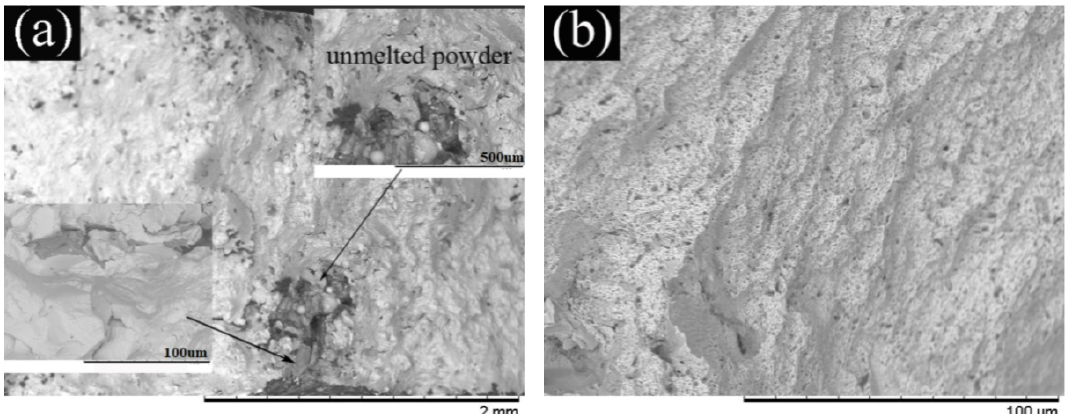
Figure 12. The uniaxial tensile stress–strain curve of the SLM Al 0.5 CoCrFeNi HEAs.